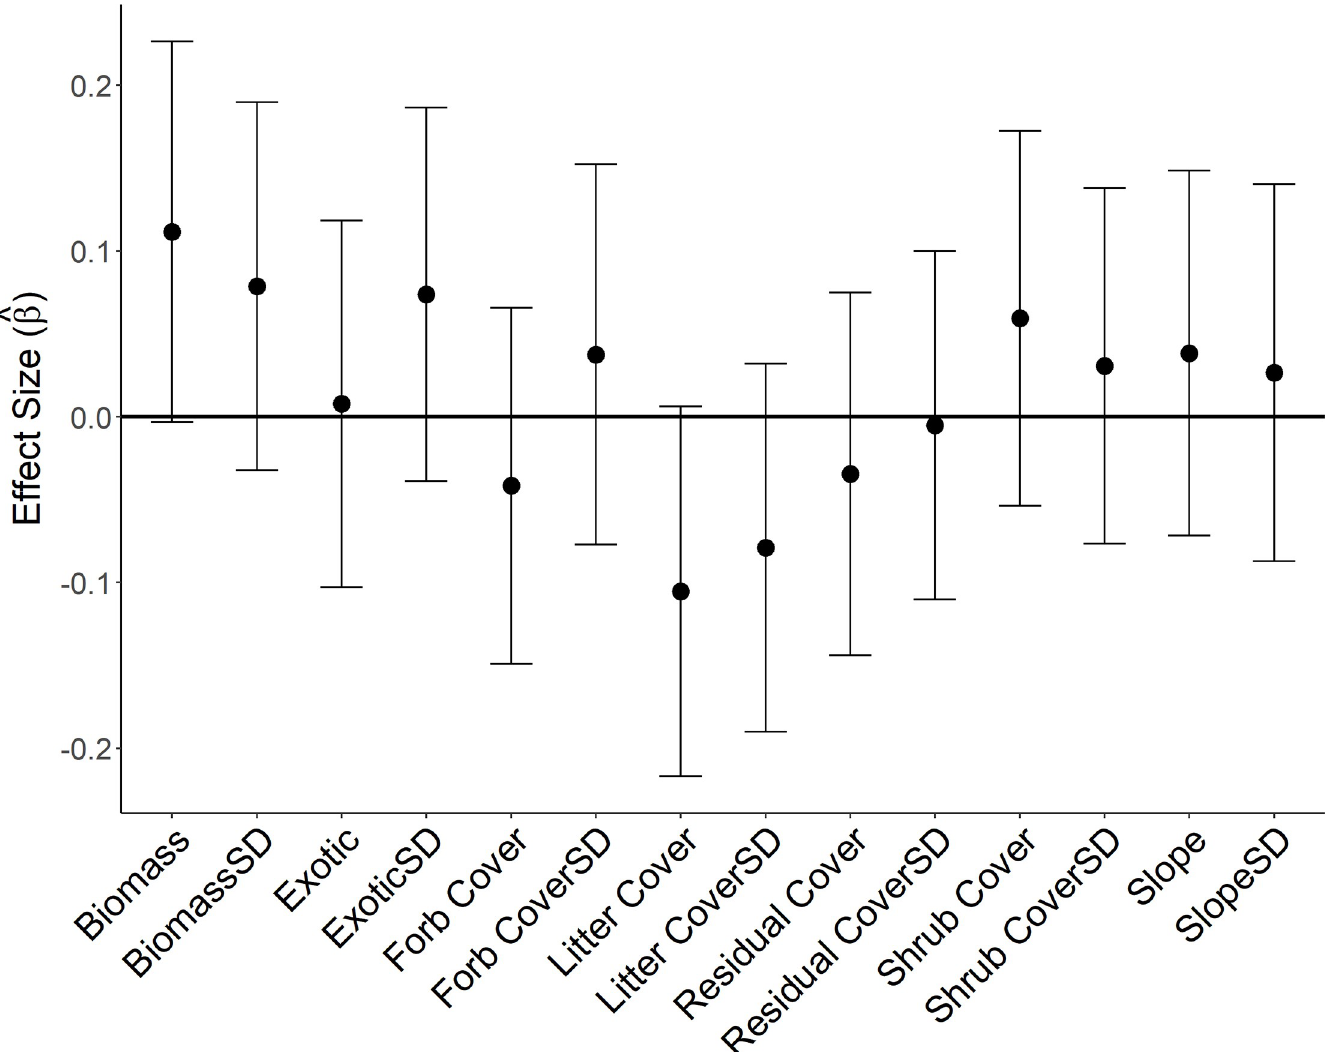
Fig 4. Estimated effect sizes of habitat features on survival of chestnut-collared longspur nests. Estimated effect sizes and 95% confidence intervals from standardized covariates measured at the plot scale on daily survival of 263 chestnut-collared longspur nests in 100 9-ha plots in Phillips County, MT, during May–July of 2017 and 2018. Covariates ending in SD represent the effect of the standard deviation of the covariate at the plot scale.